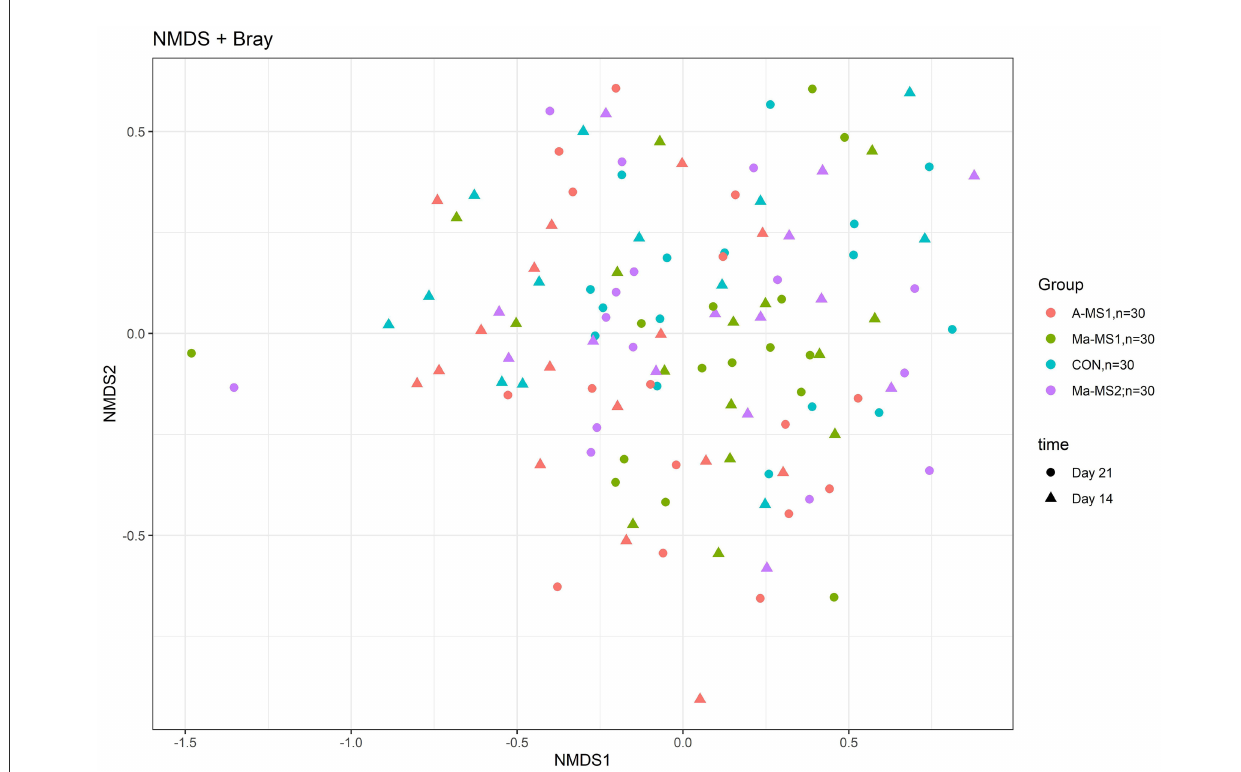
FIGURE3 Non-metric multi-dimensional scaling (NMDS) on Bray-Curtis distances at ASVs level. CON, control group without milk supplementation; A-MS1, Milk replacer supplementation 1, provided automatically; Ma-MS1, Milk replacer supplementation 1, provided manually twice a day; Ma-MS2, Milk replacer supplementation 2, provided manually twice a